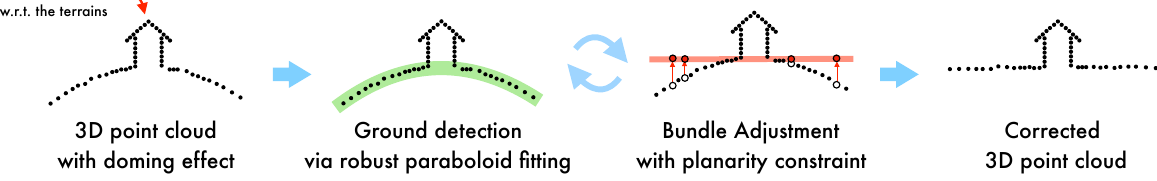
Figure 1. An overview of the main steps of the proposed method. At first the domed terrain is extracted from the point cloud via a robust paraboloid fitting technique. Hence points on the ground are selected and used to enforce a planarity constraint within an iterative Bundle Adjustment